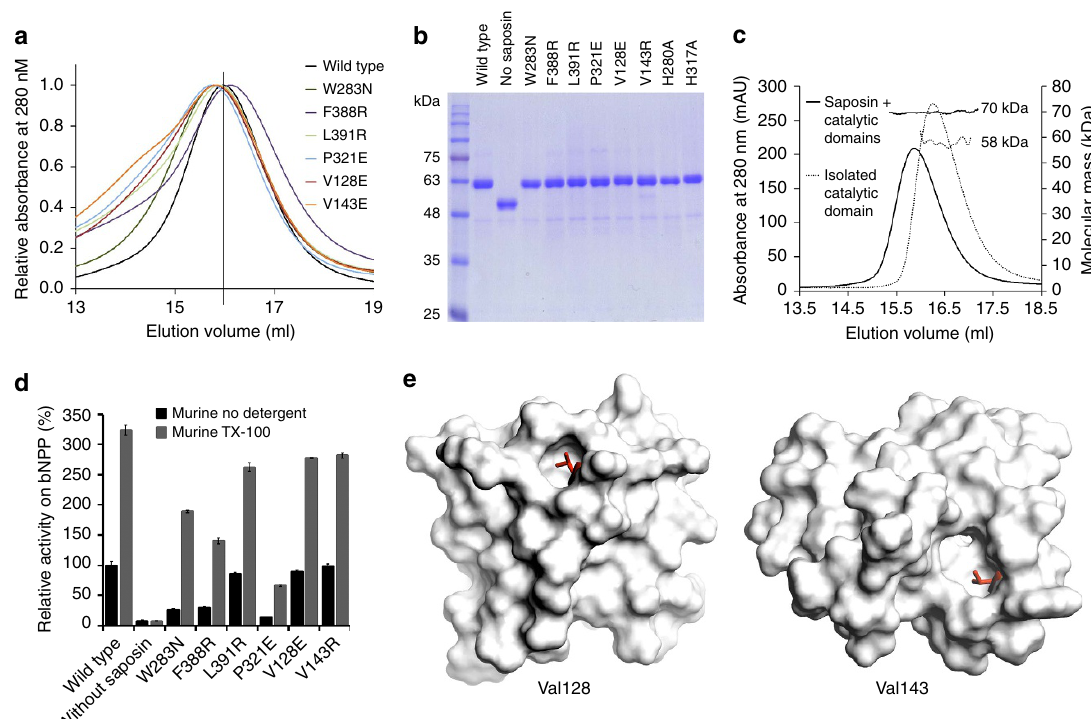
Figure 5 | Purification of murine ASMase and bNPP hydrolysis assay. ( a ) Size-exclusion chromatography elution profiles of murine ASMase and point mutants. Ultraviolet absorbance is normalized. The elution volume of the wild-type protein (vertical marker) corresponds to a molecular weight 55kDa, as extrapolated from a standard curve. ( b ) SDS–polyacrylamide gel electrophoresis of purified mutants. ( c ) Multi-angle light-scattering measurements of ASMase and the isolated catalytic domain. ( d ) Activity measurements of bNPP hydrolysis by ASMase interface mutants with added detergent (dark grey bars). 100% activity corresponds to 1.76 m M bNPP hydrolyzed per nM protein per h for ASMase. Addition of 0.2mM Triton X-100 (TX-100) had no effect on the isolated catalytic domain. However, all interface mutants, which initially reduced enzymatic activity due to the mutation, had their activity restored to above wild-type levels. Data are the means and s.d.’s of triplicates. ( e ) We noted that the mutations on the saposin domain, V128E and V143R, had weaker inhibitory effects than those on the catalytic domain. This is likely because V128 and V143 are also important for stabilizing the closed conformation as shown (red (Fig. 7b and Supplementary Table 2). Further characterization of